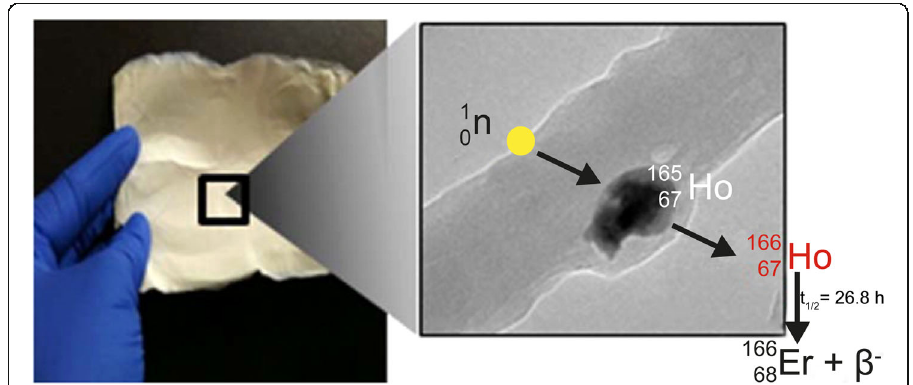
Fig. 5 Holmium polyacrylonitrile patch. Reprinted (adapted) with permission from Munaweera et al.. Radiotherapeutic bandage based on electrospun polyacrylonitrile containing holmium-166-labelled iron garnet nanoparticles for the treatment of skin cancer, Copyright 2014 American Chemical